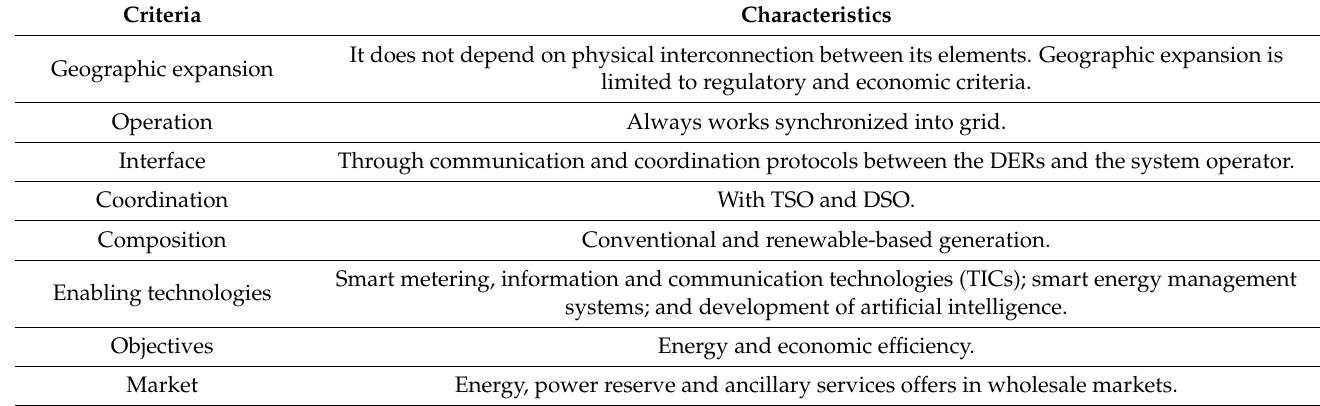
Table 1. Characteristics of VPPs .